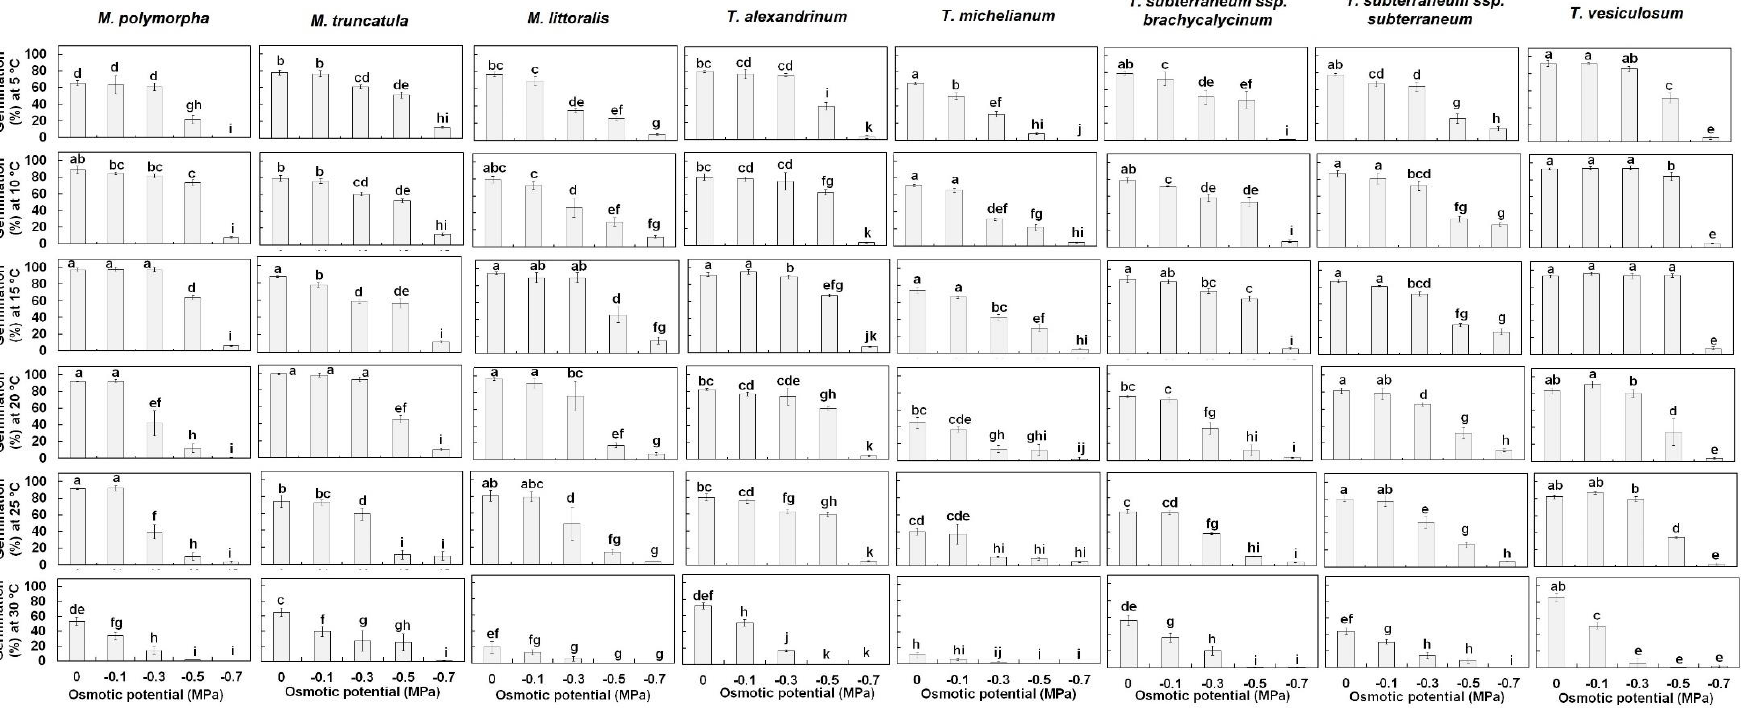
Figure 1. Seed germination (%) in three Medicago and five Trifolium species under different germination temperatures and osmotic treatments. Different letters indicate significant differences ( p < 0.05) in seed germination between different osmotic and temperature treatments. Columns with error bars represents means ± SEMs. Comparisons are made within species.